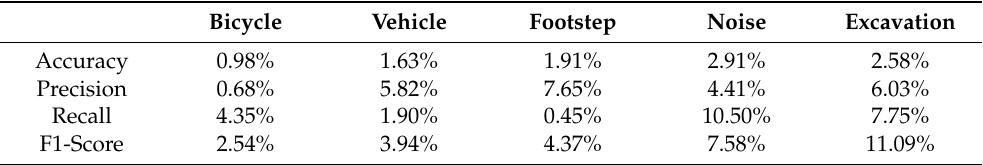
Figure 8. The confusion matrices obtained from testing sets generated by different time-frequency meth- ods. ( a ) Ensemble empirical mode decomposition and Hilbert transform (EEMD-HT) time-frequency features. ( b ) Empirical wavelet transform and Hilbert transform (EWT-HT) time-frequency features. Table 3. The improvement of proposed VMD-HT method on each class and each evaluation indicator compared with EEMD-HT and EWT-HT time-frequency